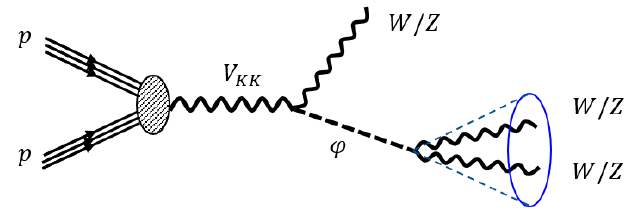
Figure 1. The benchmark process under consideration, based on an extension of the warped extra-dimensional RS models. V KK denotes the KK mode of W=Z , and corresponds to the heavier parents. ’ denotes the scalar, whose role is played by the radion. The cone around the two W=Z ’s from the ’ decay delineates that they are highly